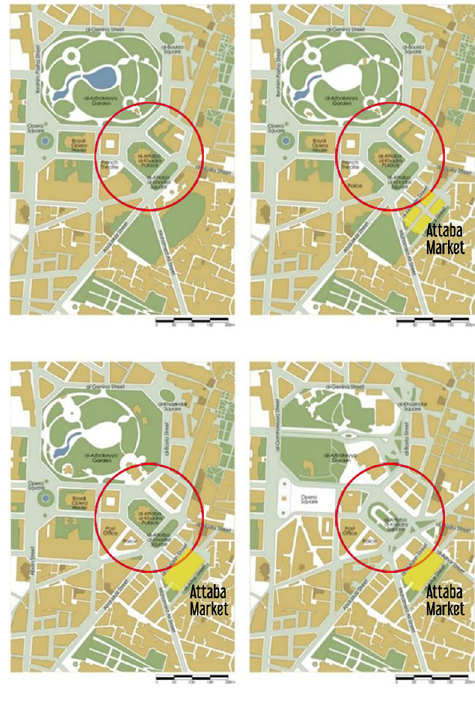
Figure 1. Maps showing urban transformation in Attaba square surroundings for the dates 1874 (up left), 1890 (upright), 1933 (bottom left) and 1980 (bottom